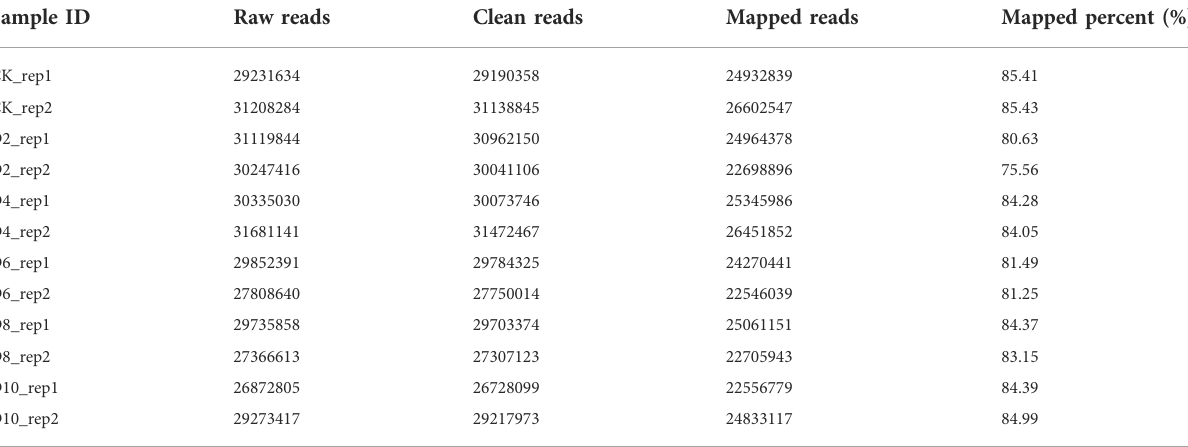
TABLE 1 Summary of the alignment